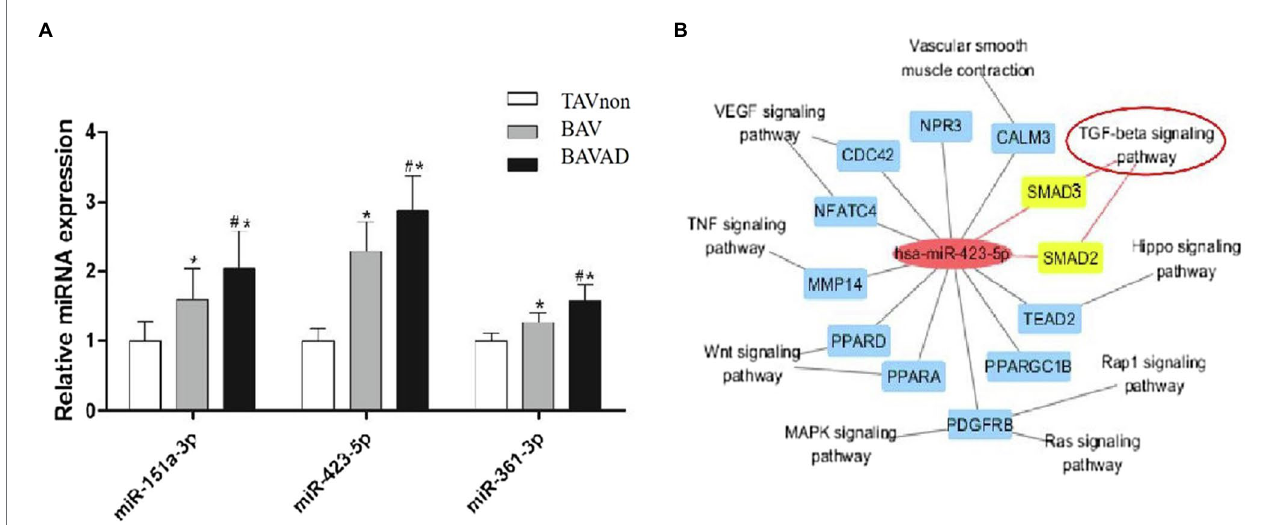
FIGURE 5 | miR-423-5p expression validation and its predicted function of regulating TGF- β signaling. (A) The validation of the key miRNA between BAVAD and BAV groups was performed by RT-qPCR. * p (BAVAD or BAV vs. TAVnon) < 0.05, # p (BAVAD vs. BAV) < 0.05; one-way ANOVA. (B) Interactive miR-423-5p/mRNA/ pathway network. The yellow-marked mRNA is a key target for miR-423-5p to participate in TGF- β signaling